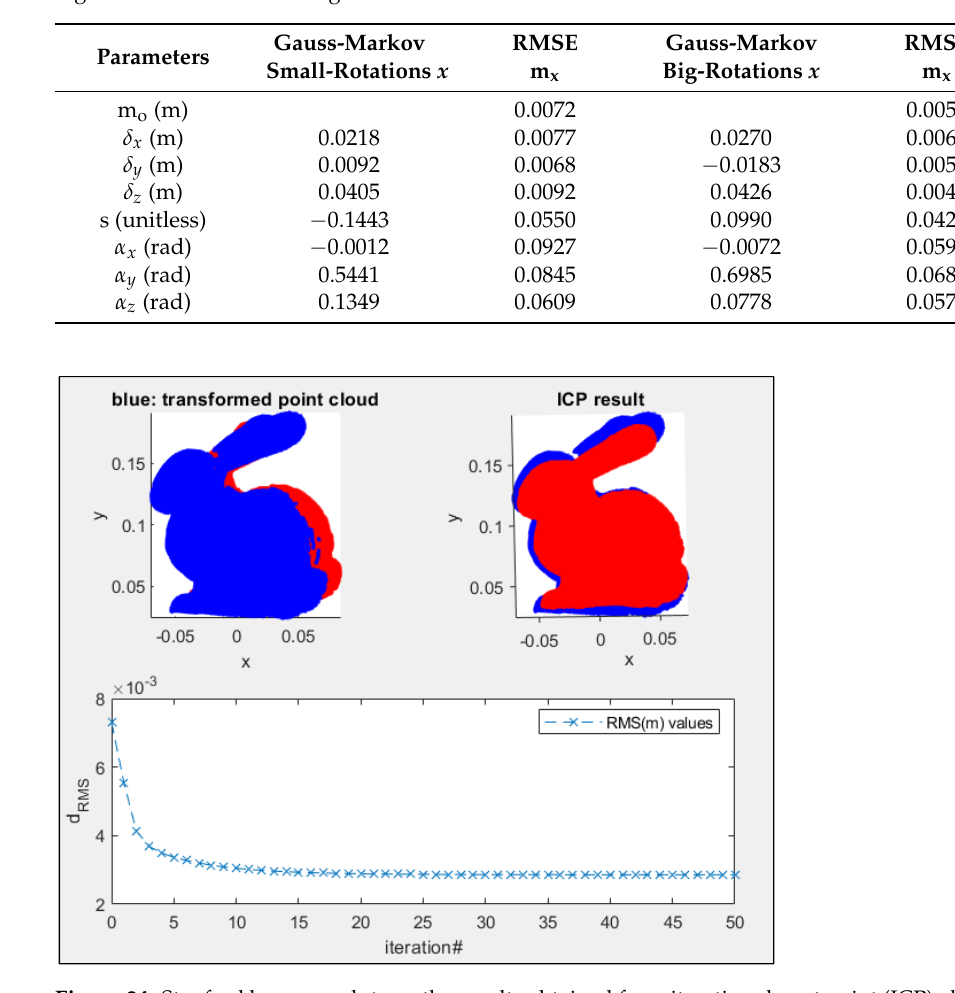
Figure 24. Stanford bunny sculpture: the results obtained from iterative closest point (ICP) algorithm where the keypoints identified and matched by the new algorithm are used.